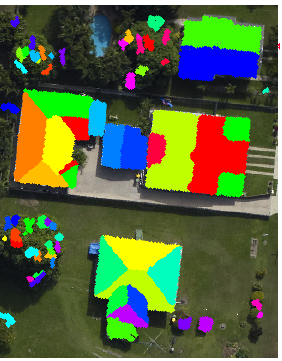
Figure 5: Initial planar segments of a data set marked by different colours and projected on an